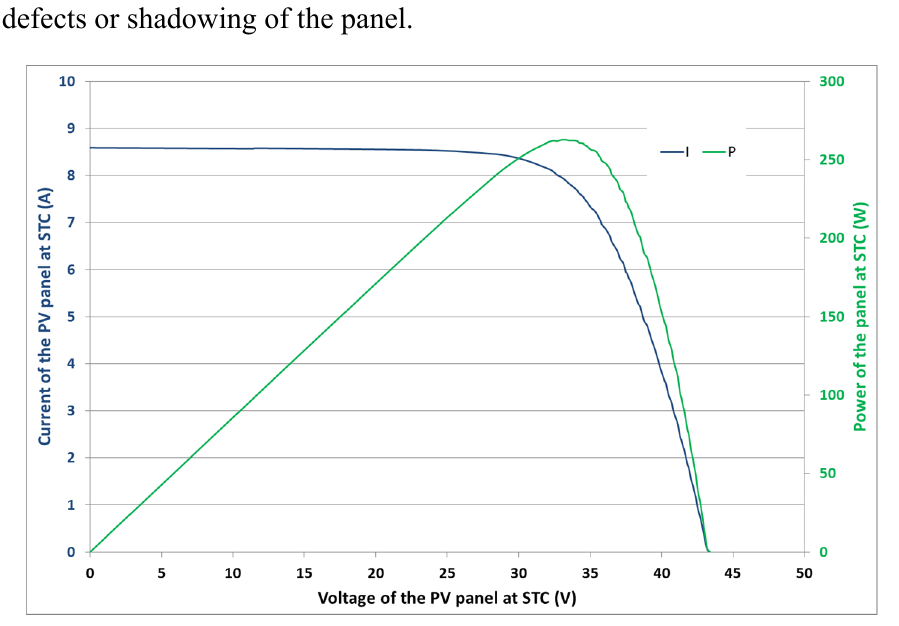
Figure 8. I-V curve of the tested PV panel